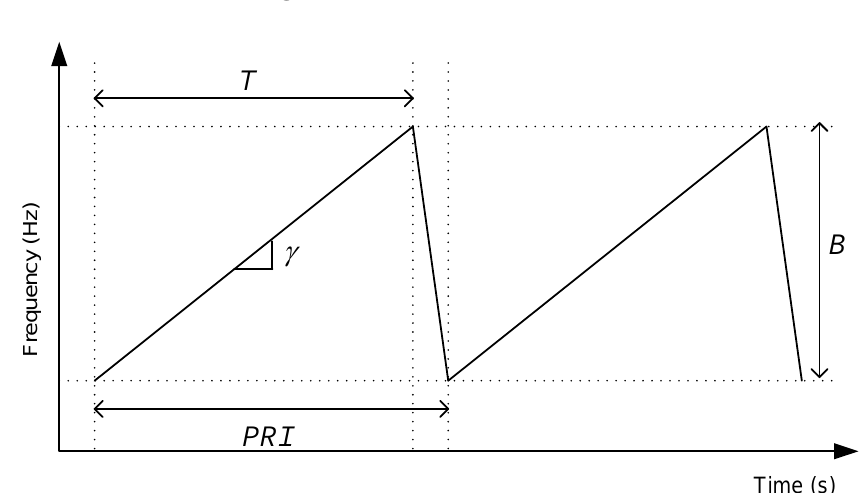
Figure 2. LFM-CW